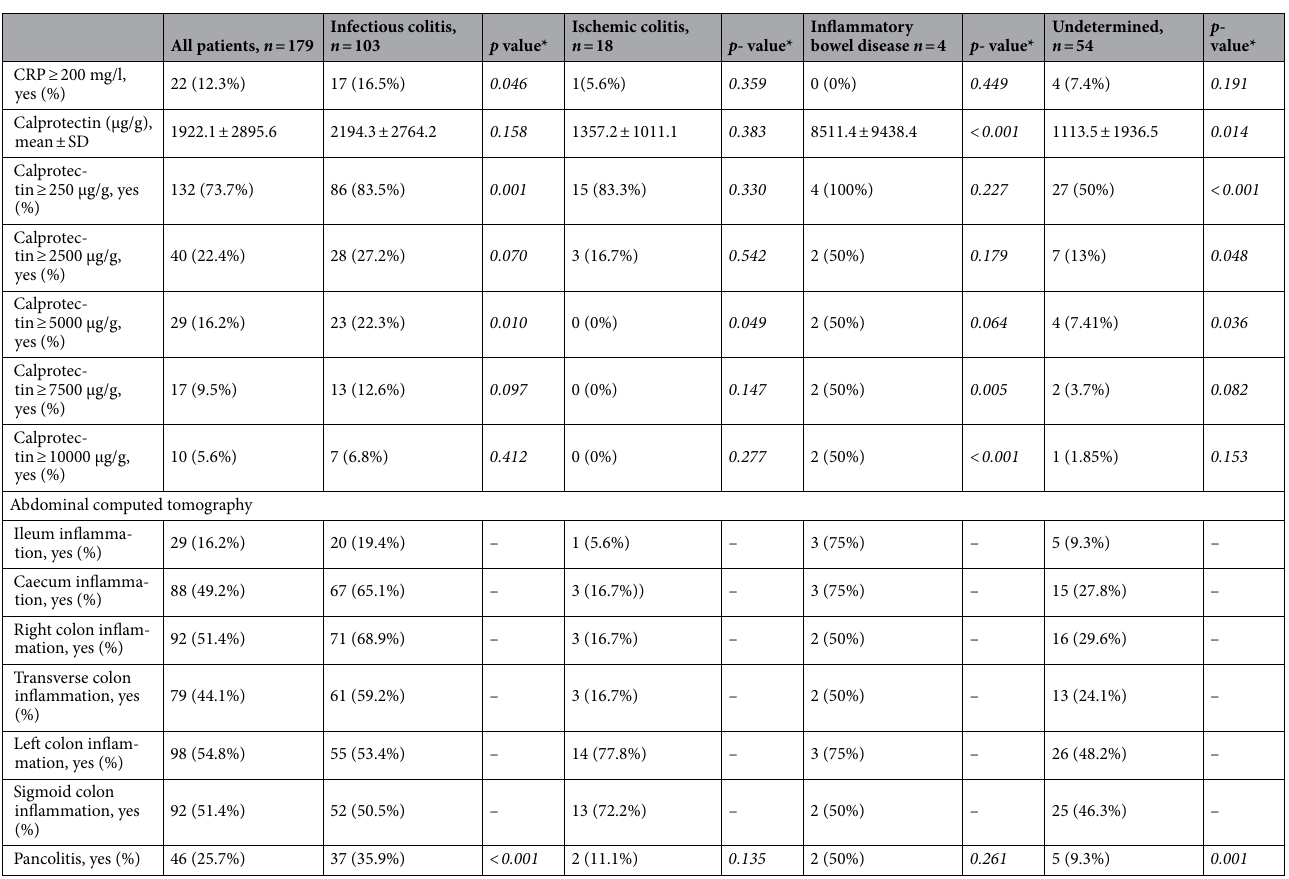
Table 1. Characteristics of included patients. NSAID non-steroidal anti-inflammatory drugs. *When compared to the rest of the